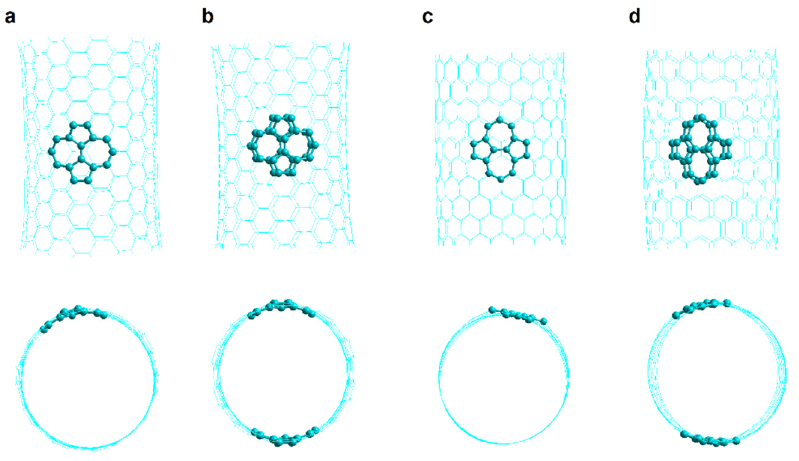
Figure 7. Representation of carbon nanotubes having one and two Stone–Wales defects. (a) SW1 armchair; ( b ) SW2 armchair; ( c ) SW1 zigzag; ( d ) SW2 zigzag. Side and front views shown.